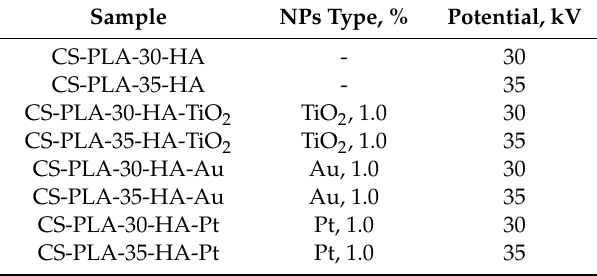
Table 1. Three-Dimensional biomaterials’